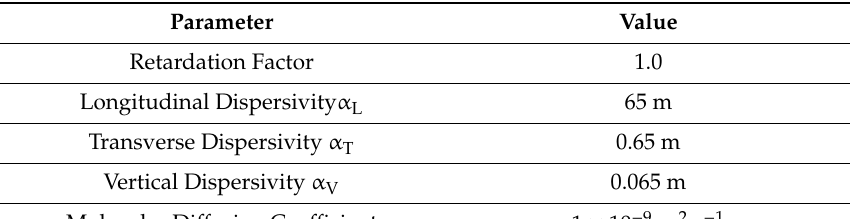
Table 1. Calibrated Parameters for the Transport Model [12,22].